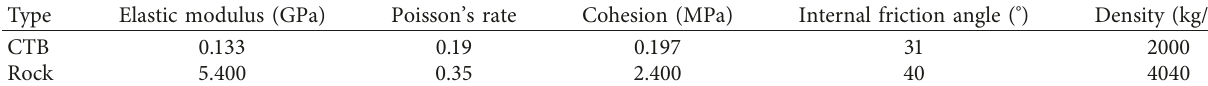
Table 3: Physical mechanical parameters of CTB and rock